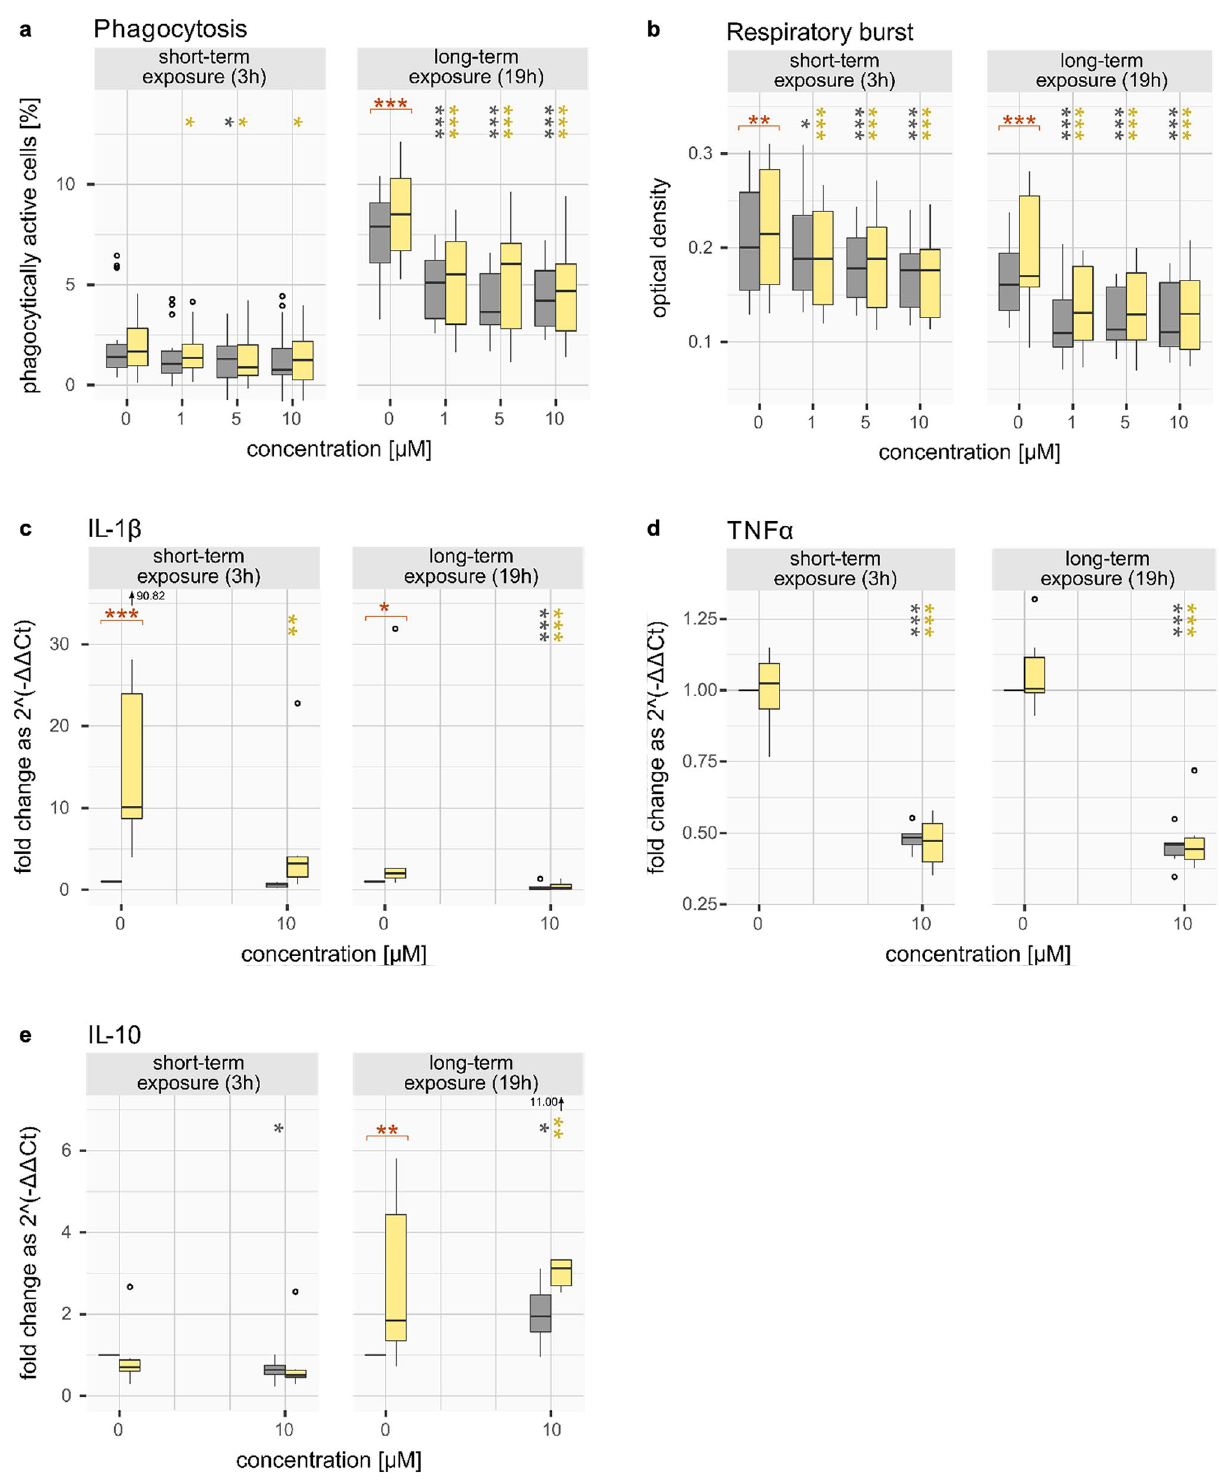
Figure 2. Effects of the reference compound dexamethasone on the immune parameters: phagocytosis ( a ), respiratory burst ( b ) and the mRNA transcript levels of IL-1β ( c ), TNFα ( d ) and IL-10 ( e ) . Results are shown after short- and long-term exposure with dexamethasone—without (gray) or with (yellow) previous LPS stimulation. Significant differences of the chemical treatments compared to the respective controls are indicated with gray or yellow asterisks, respectively. Significant differences of the control without LPS compared to the control with LPS are indicated with orange asterisks. p values < 0.001 for ***; < 0.01 for ** and < 0.05 for